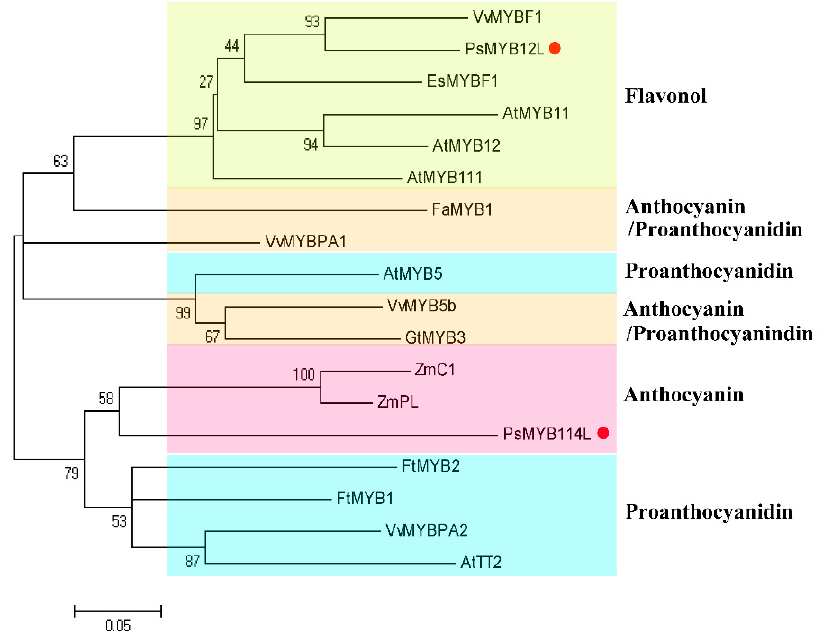
Figure 3. Phylogenetic analysis of the PsMYB114L and PsMYB12L genes with R2R3-MYB TFs from other species. The NCBI GenBank accession numbers of these sequences are as follows: FaMYB1 , Fragaria x ananassa , AF401220.1; VvMYBPA1, Vitis vinifera, NM_001281231.1; VvMYB5b , Vitis vinifera,